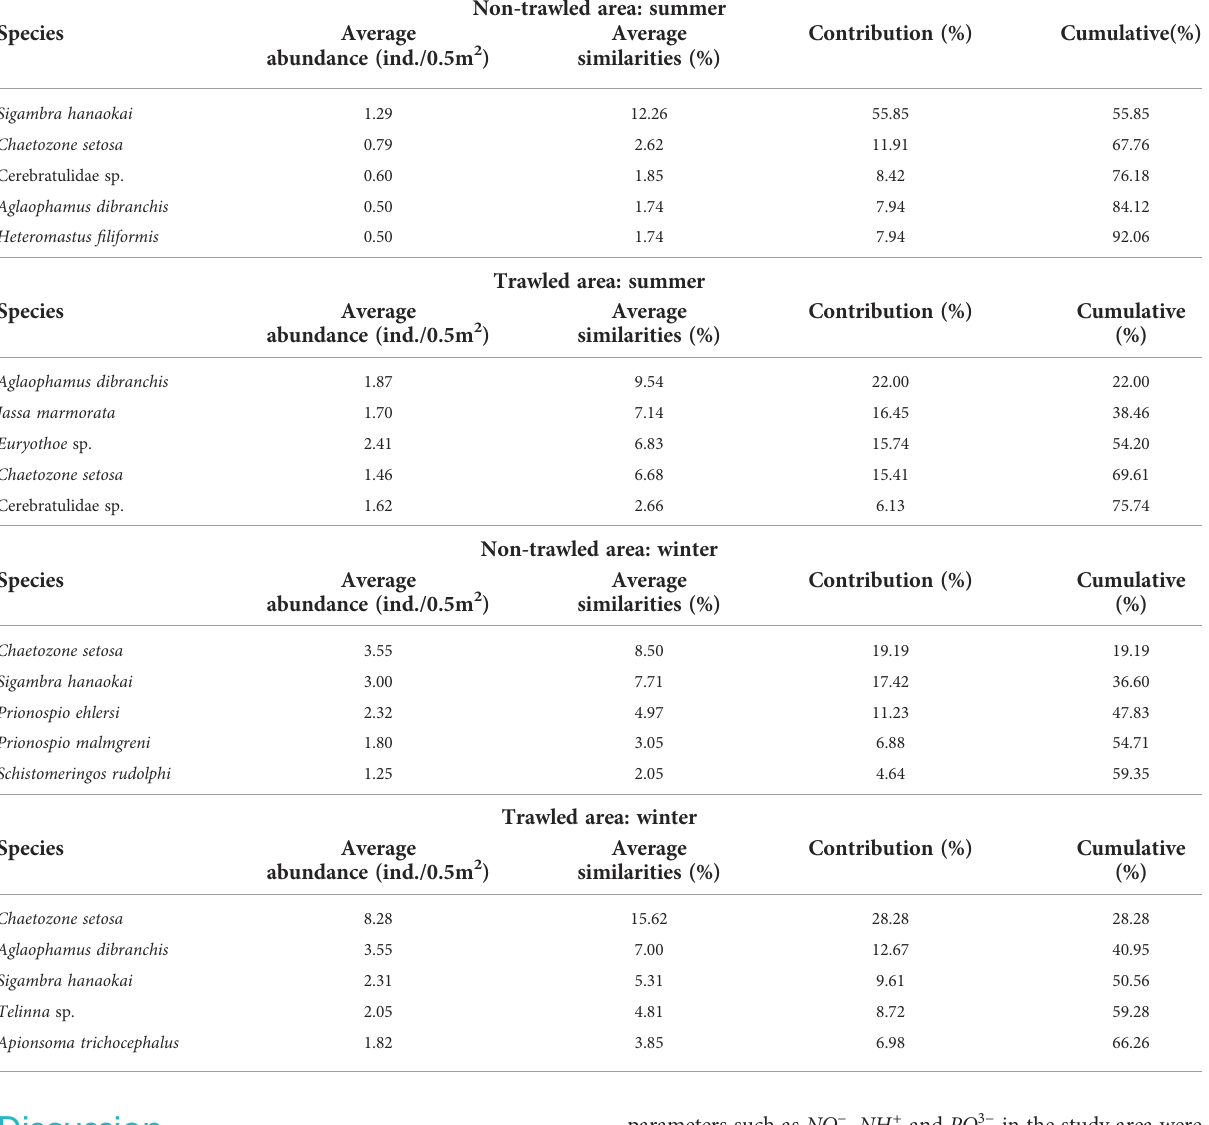
TABLE 3 The top fi ve species contribution from SIMPER (Similarity Percentages) for summer and winter